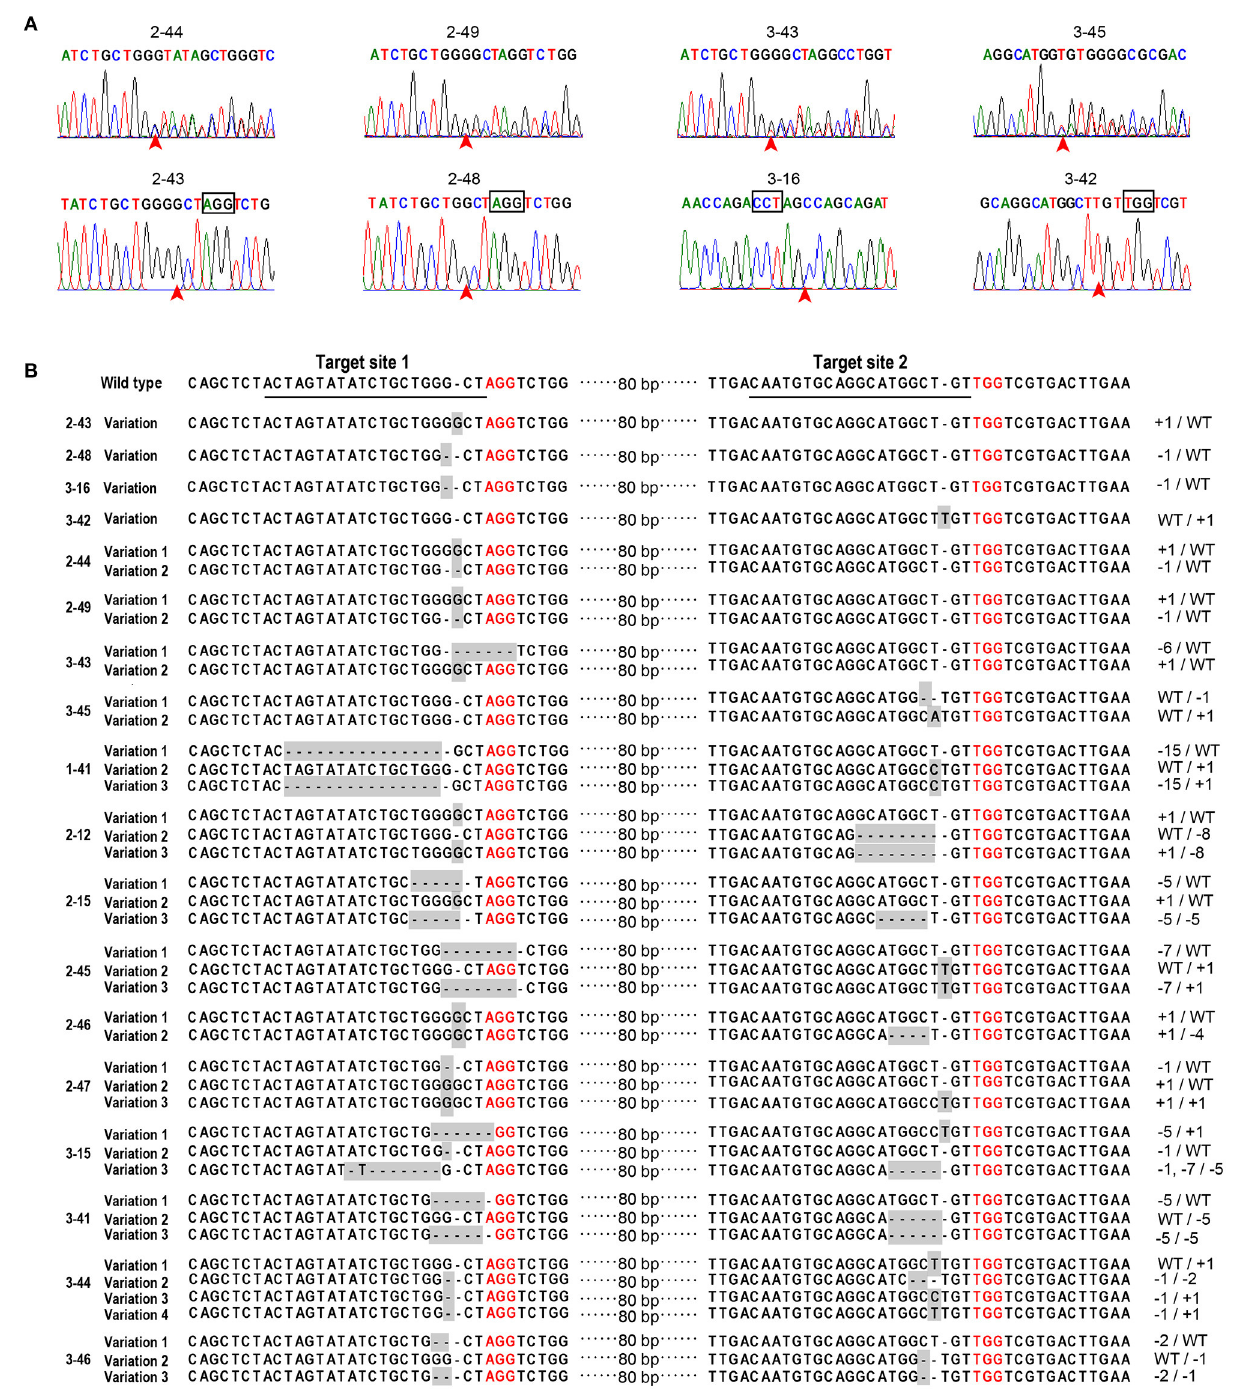
FIGURE 3 | Sequences at the target sites in albino SE plants. Sequencing chromatograms of biallelic (2–44, 2–49, 3–43, and 3–45) and homozygous (2–43, 2–48, 3–16, and 3–42) mutations were shown in (A) . The red arrows indicated the sites of mutations. The edited sequences in the 18 albino SE plants were listed in (B) . The sequences at the target site 1 and the target site 2 in wild-type SE plants of WSP3 were underlined. PAM sites were indicated with red color. The line number of the individual transgenic line was indicated on the left side of the sequence. The nucleotide insertion and deletion were indicated by + n bp and -n bp, respectively, on the right side of the